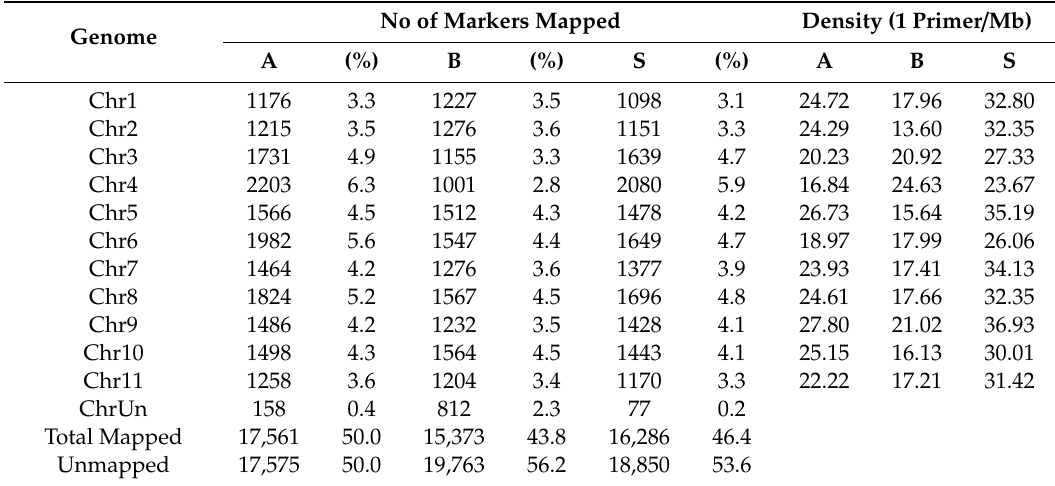
Table 2. Summary of chromosomal distribution and average density of SSR markers mapped on